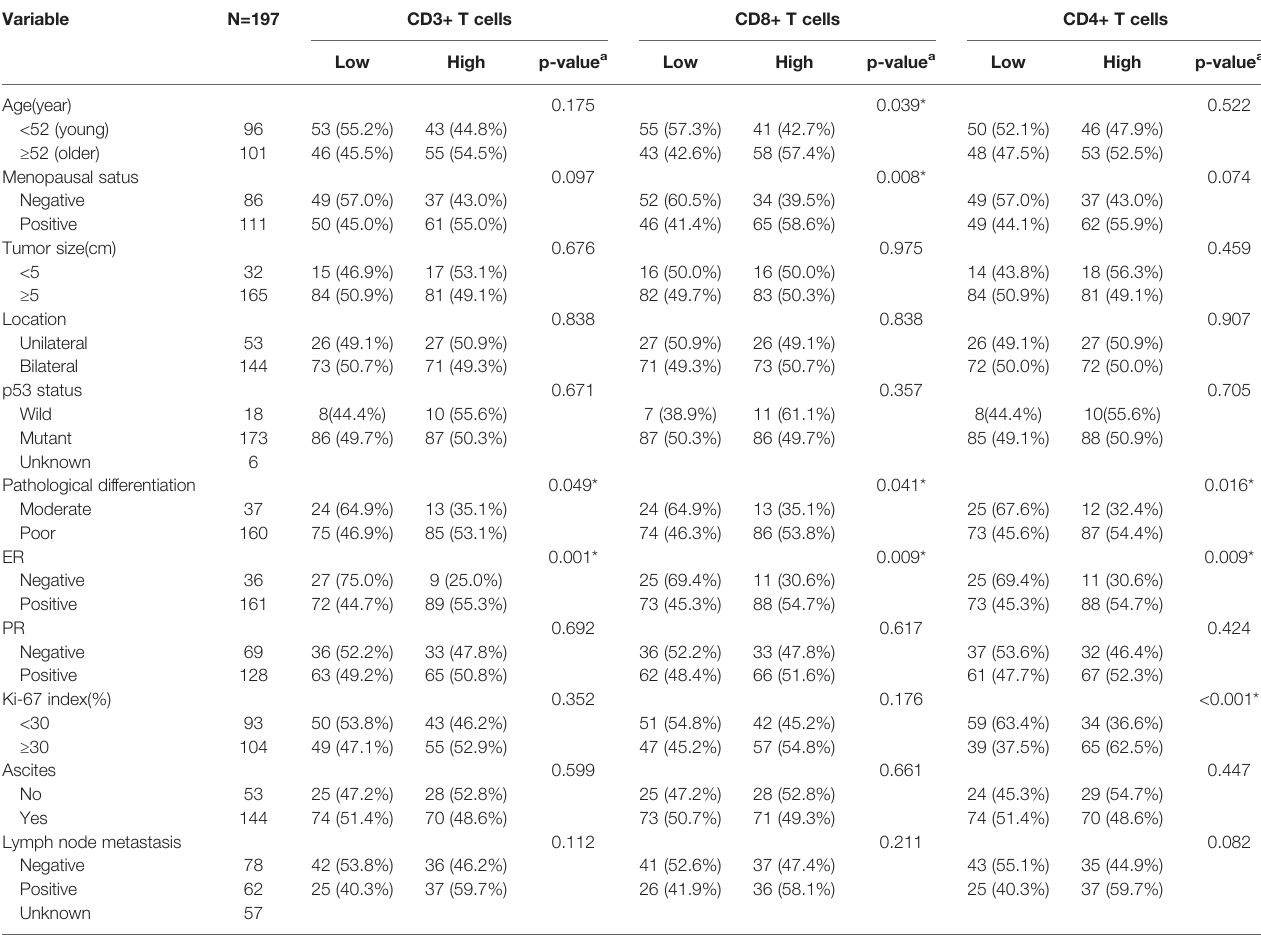
TABLE 2 | Association between clinicopathological characteristics and tumor in fi ltrating T cells.